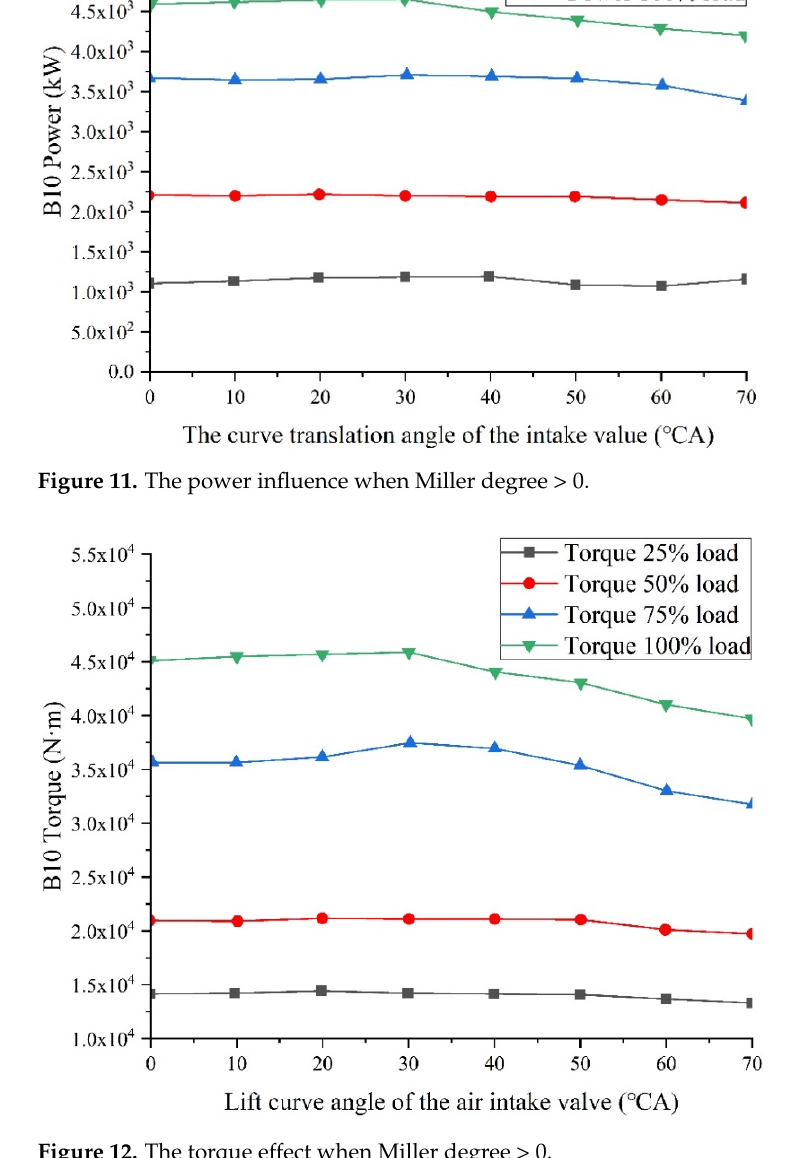
Figure 12. The torque effect when Miller degree > 0.